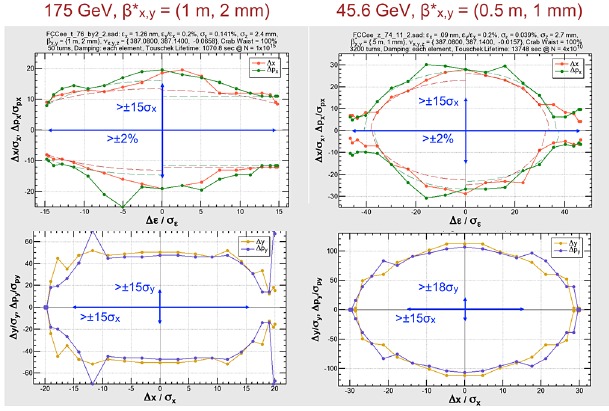
FIG. 13. Dynamic aperture for the FCC-ee interaction region variant 2 (50 turns, without damping, crab sextupole is off, rf is on).